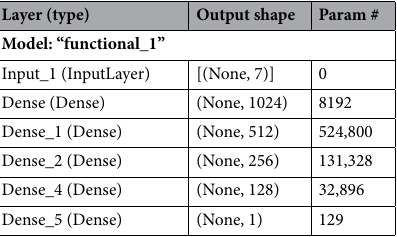
Middle Bakken, and the Lower Bakken. The Upper and Lower Bakken members mainly consists of dark-gray to brownish-black to black, fissile, slightly calcareous, organic-rich shale, which was deposited in an offshore marine environment. The DL model has been applied to the 4 wells 37,38 (A, B, C, D wells in the Fig. 1). The Upper and Lower Bakken shales are represented by beginning of late oil windows with average of 0.92% Requ in the wells. TOC contents range from 6.58 to 16.69 wt.% with an average of 11.44 wt.%. Quartz, clay and carbonate contents are 45.75%, 42.09% and 1.10%, respectively. Predicted S1 volumes of the Bakken Shales vary from 1.3 to 7.6 mg oil/g TOC with an average of 3.64 mg oil/g TOC based on the DL model. In addition, average of evapora- tion loss corrected S1 volumes with 40 API gravity is 4.86 mg oil/g TOC. Thus, the average oil saturation index (OSI) of the Upper and Lower Bakken Shales has been calculated as 42.83 mg oil/g TOC (Table 3 and Datashare 1). The data show that the shales have lower reservoir quality and lower oil production rate because the OSI is very close to threshold accepting as 40 mg oil/g TOC 7–9 , or lower than accepting as 100 mg oil/g TOC 6 . The find- ing well-matches with former studies 6,39 on the Bakken Shales.